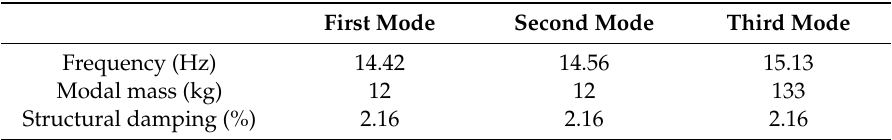
Figure 5. Mode shapes of the electrical cabinet: ( a ) First mode (x-direction); ( b ) Second mode (x-direction); ( c ) Third mode (y-direction); and ( d ) Fourth mode (x-direction). Table 3. Dynamic properties of the electrical cabinet.